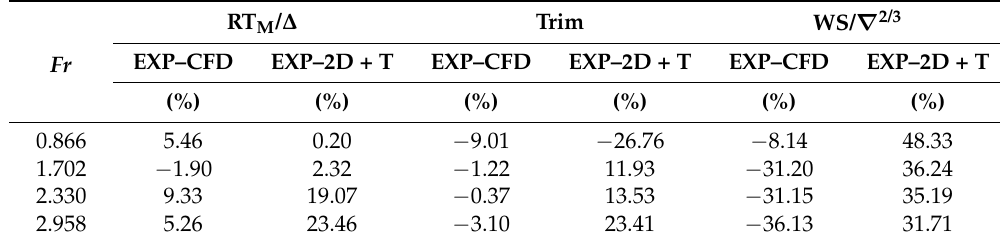
Table 3. CFD vs. 2D + T results: comparison errors.